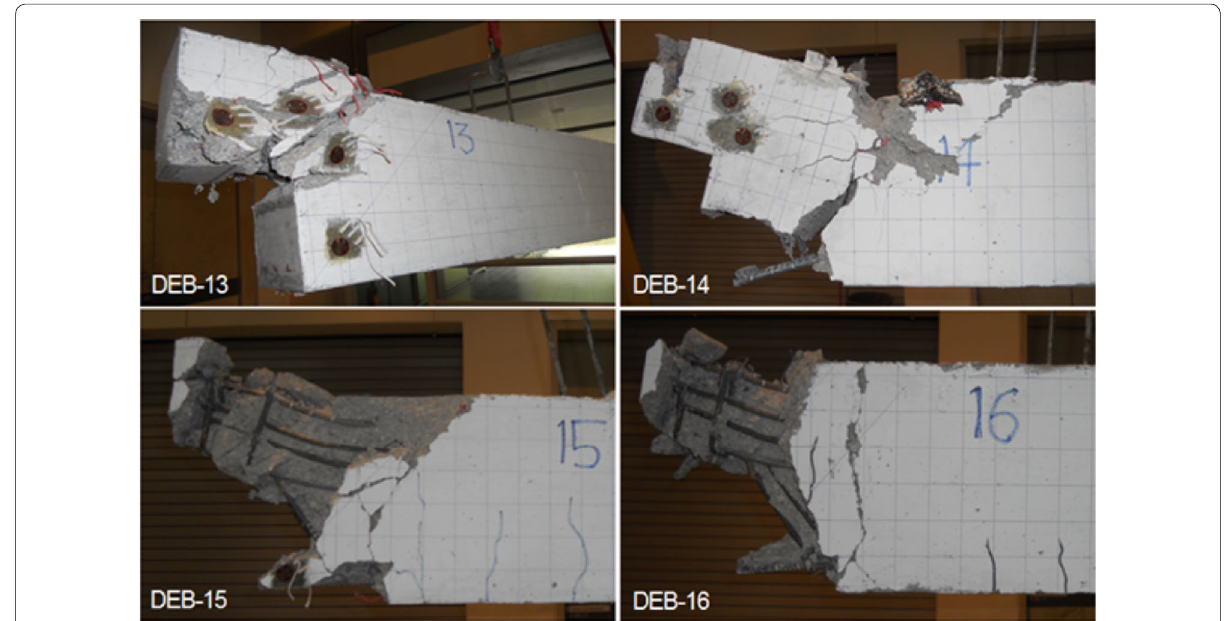
Fig. 17 The beams condition after testing (For DEB-13,-14,-15 and